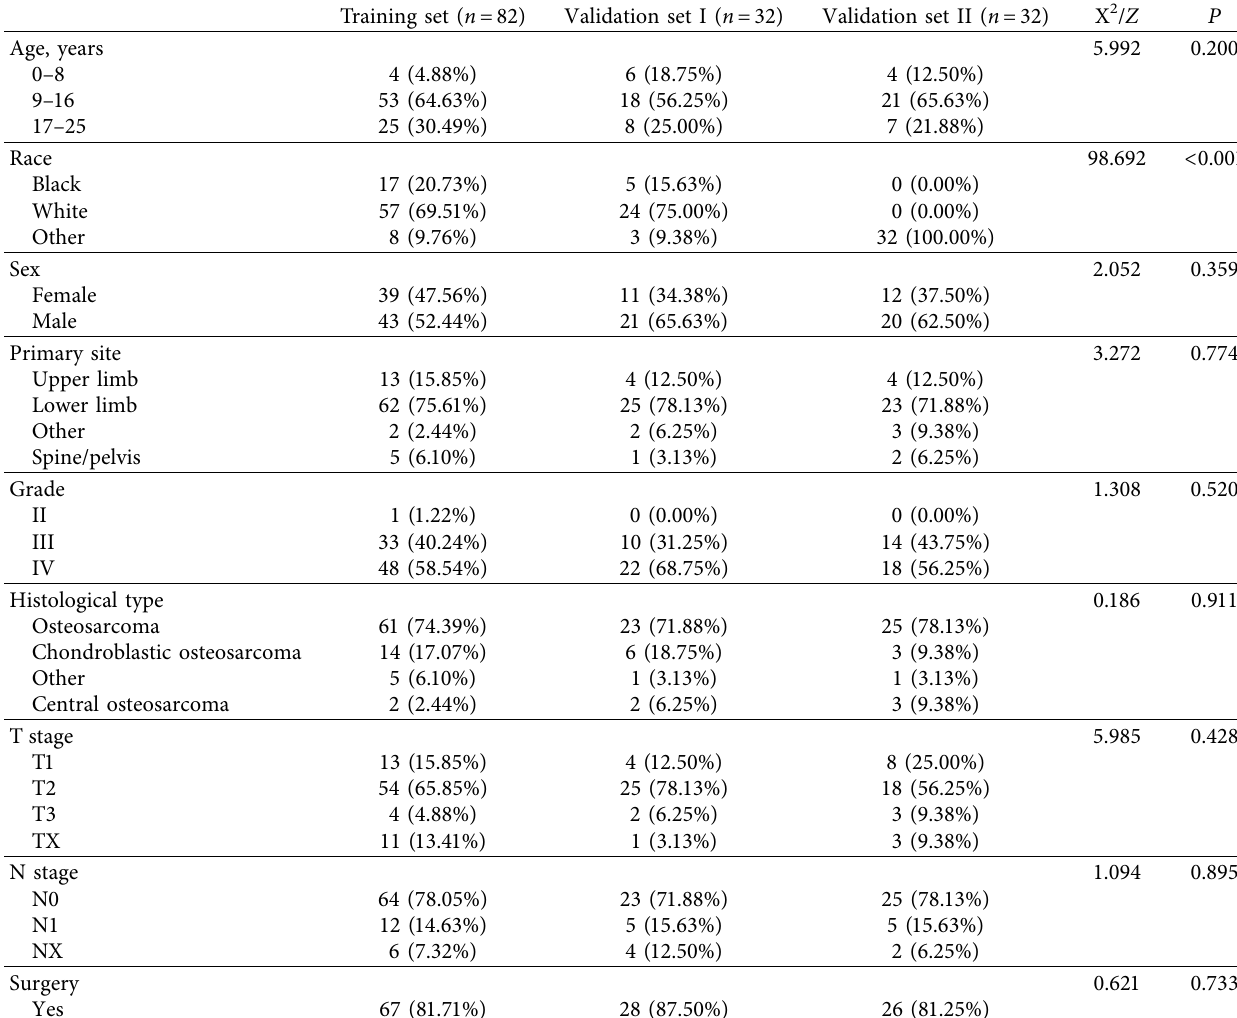
Figure 3: The calibration curve of the nomogram in the training set (a), internal validation set (b), and external validation set (c); the decision curve analysis of the nomogram in the training set (d), internal validation set (e), and external validation set (f). Table 3: Clinical characteristics of 114 osteosarcoma patients with